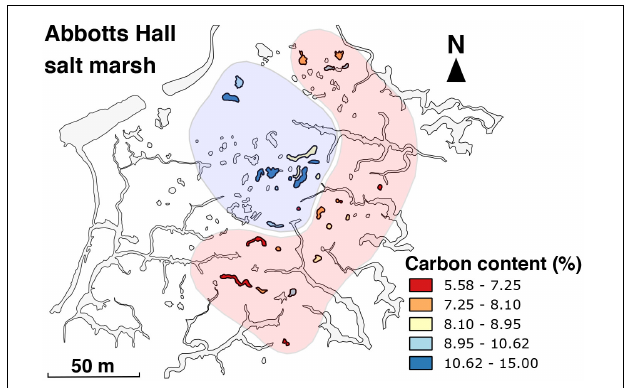
FIGURE 11 | Distribution of organic carbon content (%) in the top 5 cm of pond sediment. Hand-drawn zones of ‘high’ and ‘low’ organic carbon content represent the overall